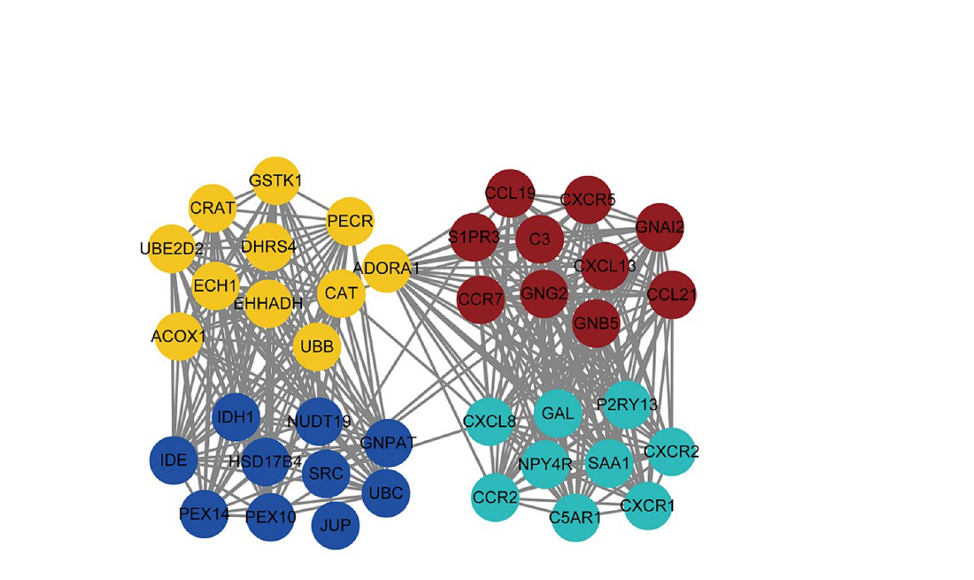
Figure 4. Network diagram of hub gene interactions made by cytoHubba plugin (http://apps.cytos cape.org/ apps/cytoh